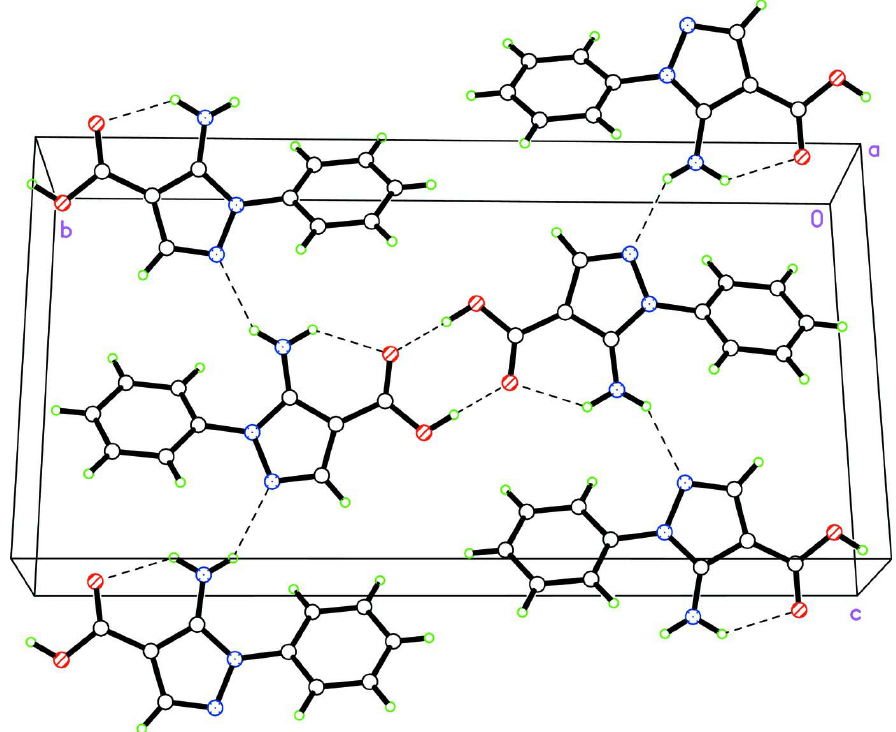
Figure 2 Perspective view of the crystal packing showing hydrogen-bond interactions (dashed lines). H atoms not involved in hydrogen bonding have been omitted for